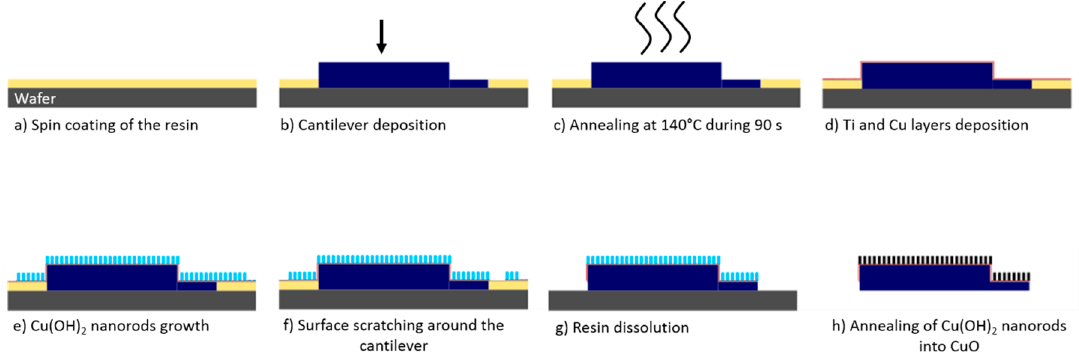
Figure 3. Schematic representation of the protocol developed to overcome the border effect observed during the nanorods synthesis on the cantilever surface.